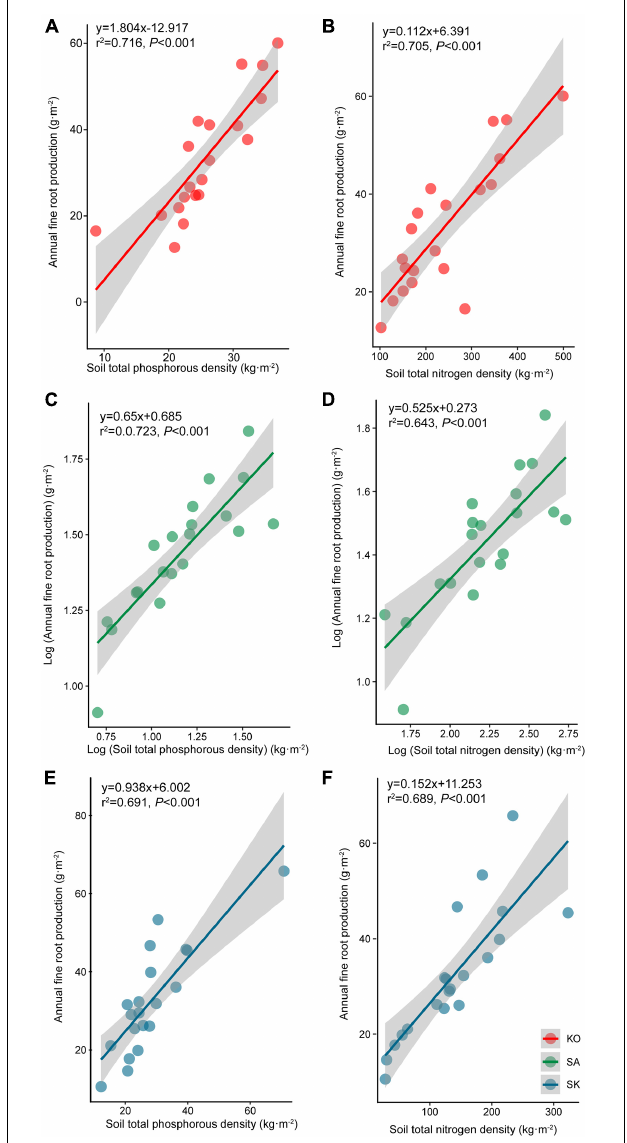
FIGURE 5 | Regression analysis between soil total phosphorous (A–C) and nitrogen content (D–F) and annual fine root production for S. apetala (SA), K. obovata (KO) monocultures and the mixed (SK) plantations at Hanjiang River Estuary, south China.